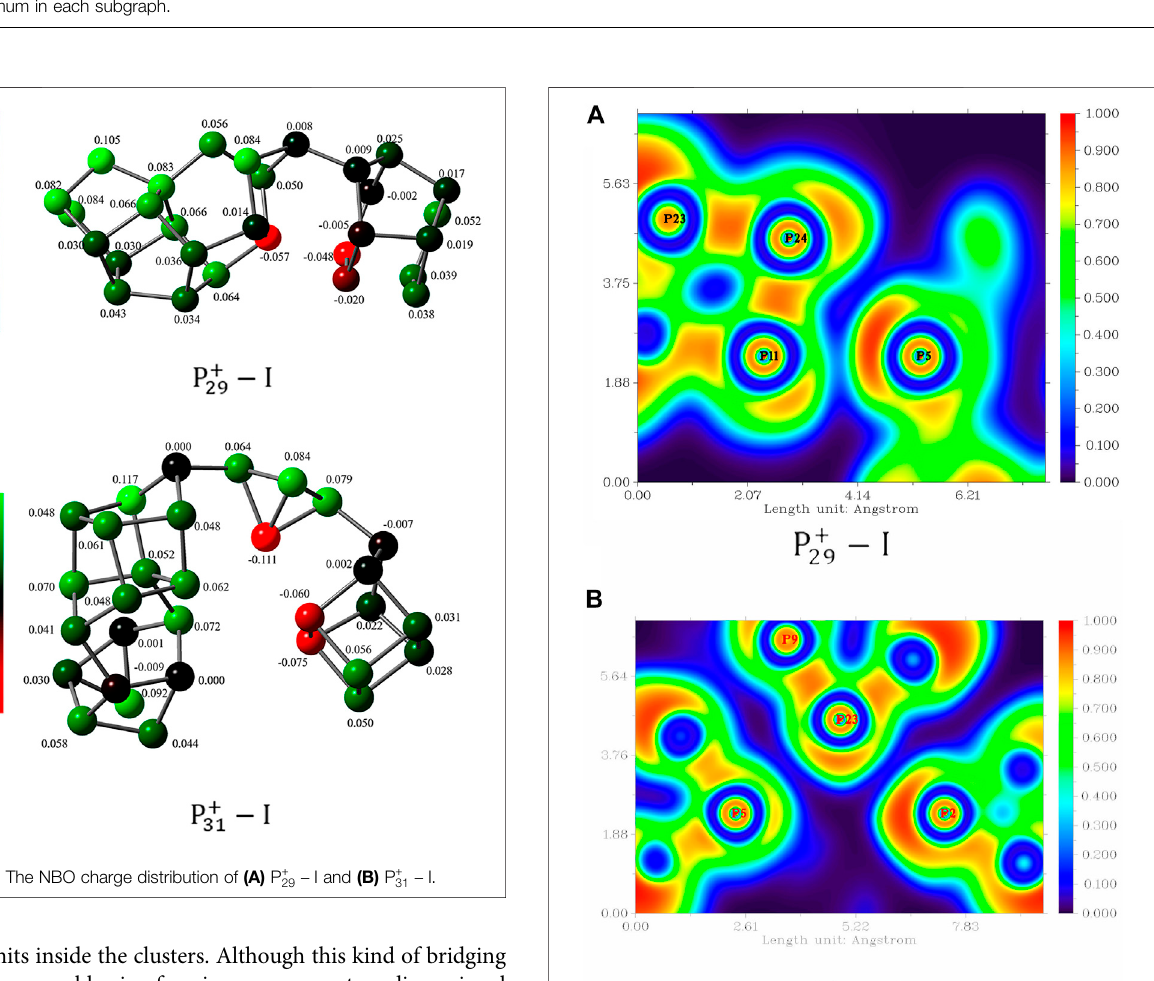
Frontiers in Chemistry |